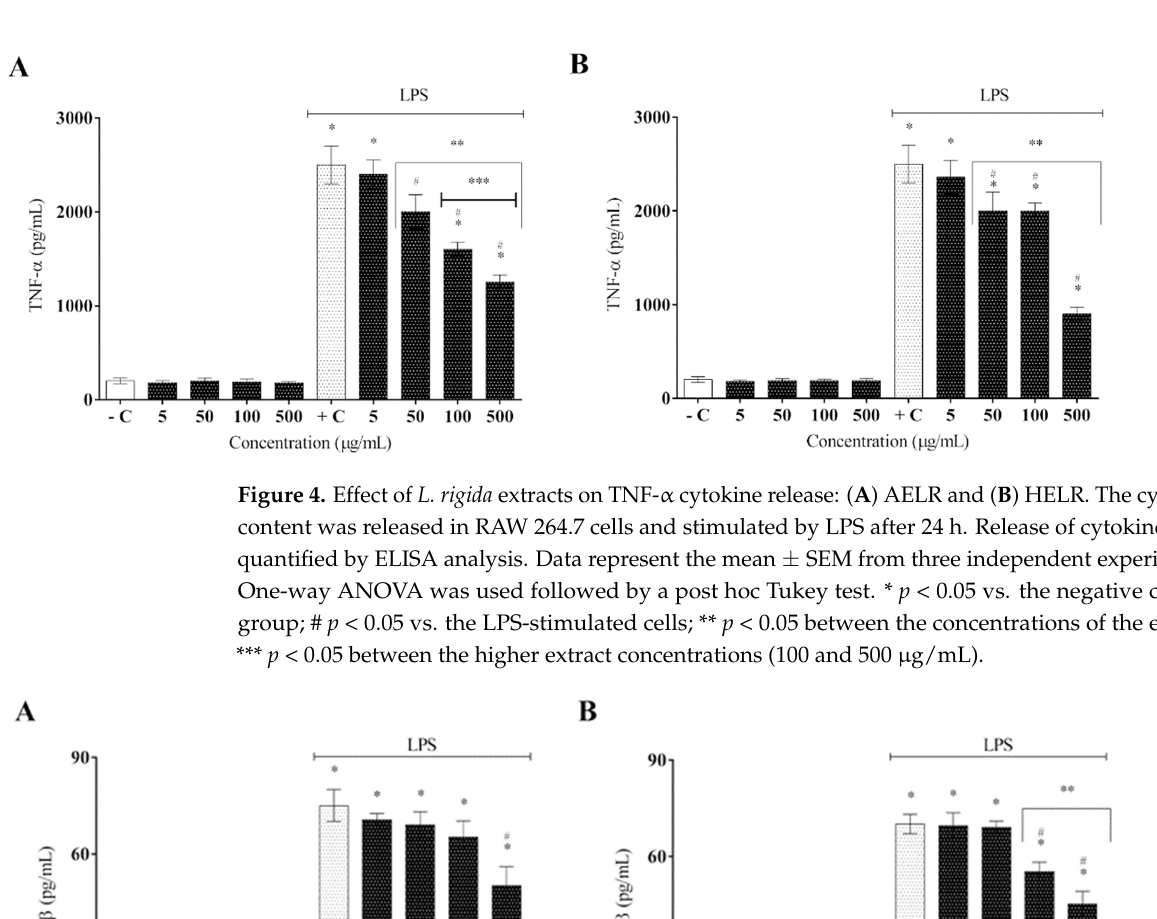
Figure 6. Effect of L. rigida extracts on IL-6 cytokine release: ( A ) AELR and ( B ) HELR. The cytokine content was released in RAW 264.7 cells and stimulated by LPS after 24 h. Release of cytokines was quantified by ELISA analysis. Data represent the mean ± SEM from three independent experiments. One-way ANOVA was used followed by a post hoc Tukey test. * p < 0.05 vs. the negative control group; # p < 0.05 vs. the LPS-stimulated cells. Acute inflammation was LPS-induced in vivo in the peritoneal cavity of C5,7BL/6 male mice to determine the ability of the L. rigida extract to inhibit inflammatory cytokine infiltration at the injury site. The LPS-stimulated animals (positive control) showed a significant increase in inflammatory cytokines in the peritoneal cavity ( p < 0.05) compared with the non-stimulated group (negative control), confirming the inflammatory process induced by LPS (Figure 7A–C). In animals with LPS-induced inflammation, treatment with aqueous and hydroethanolic extracts resulted in a significant decrease in inflammatory cytokine infiltration into the peritoneal cavity ( p < 0.05). Both the aqueous and hydroethanolic extracts inhibited TNF- α secretion, although HELR displayed a more satisfactory result, with a reduction of approximately 50% (Figure 7A). Both extracts reduced IL-1 β secretion, with HELR reaching greater than 50% inhibition (Figure 7B). Both extracts reduced IL-6 secretion by approximately 50% (Figure 7C).